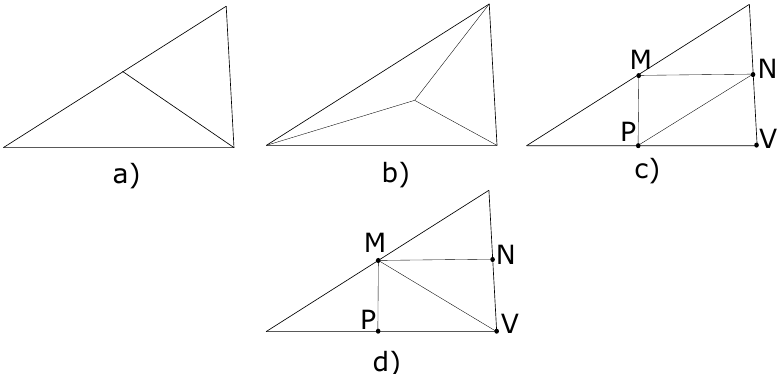
Figure 7. Common refinement of triangles includes ( a ) 1:2 ( b ) 1:3 and ( c ) 1:4. Shown in ( d ), a 1:4 composite refinement scheme can also be created by two applications of 1:2 refinement in ( a